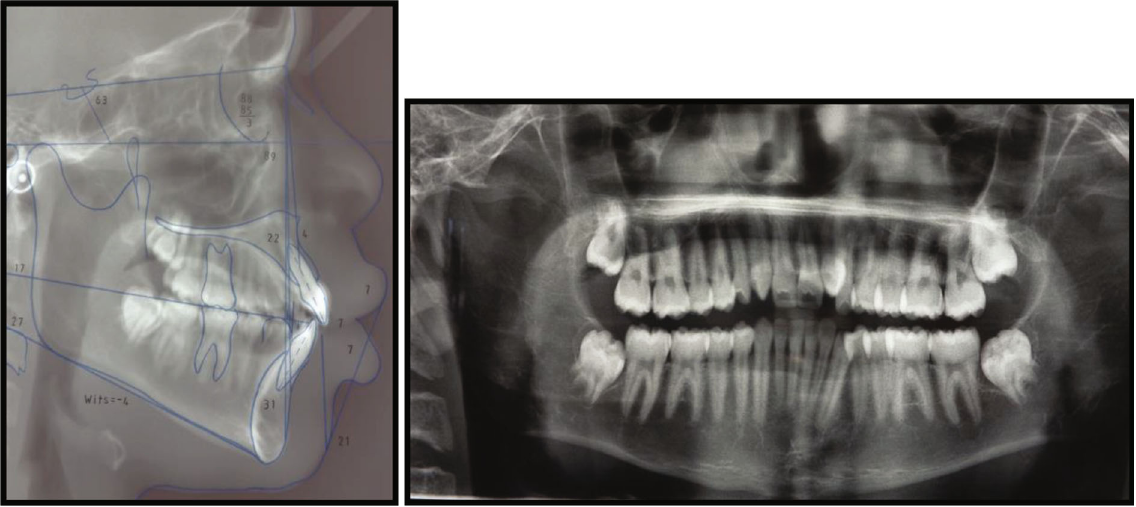
Figure 2: Pretreatment